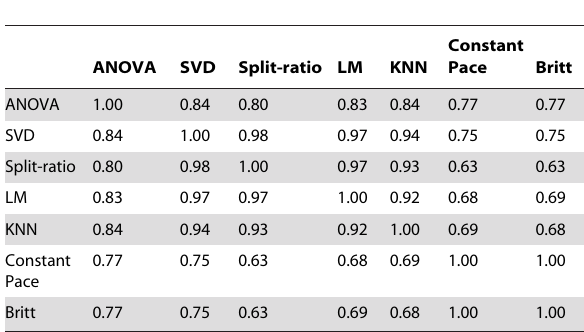
Table 7. Correlations between predictions of different